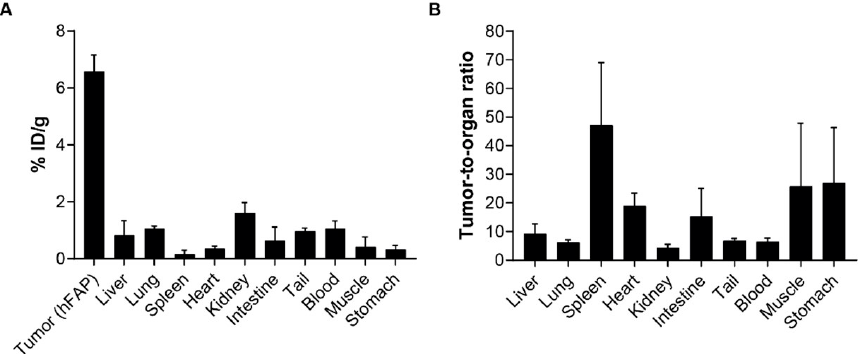
Figure 5. ( A ) Quantitative in vivo biodistribution and ( B ) tumor-to-organ ratios of [ 18 F]AlF-NOTA- OncoFAP in nude mice bearing subcutaneous HT-1080.hFAP tumors. [ 18 F]AlF-NOTA-OncoFAP was intravenously injected at 500 nmol/Kg dose (3.85 MBq/Kg), animals were sacrificed 1-h post- administration and distribution of the radiopharmaceutical was assessed by gamma-counter.